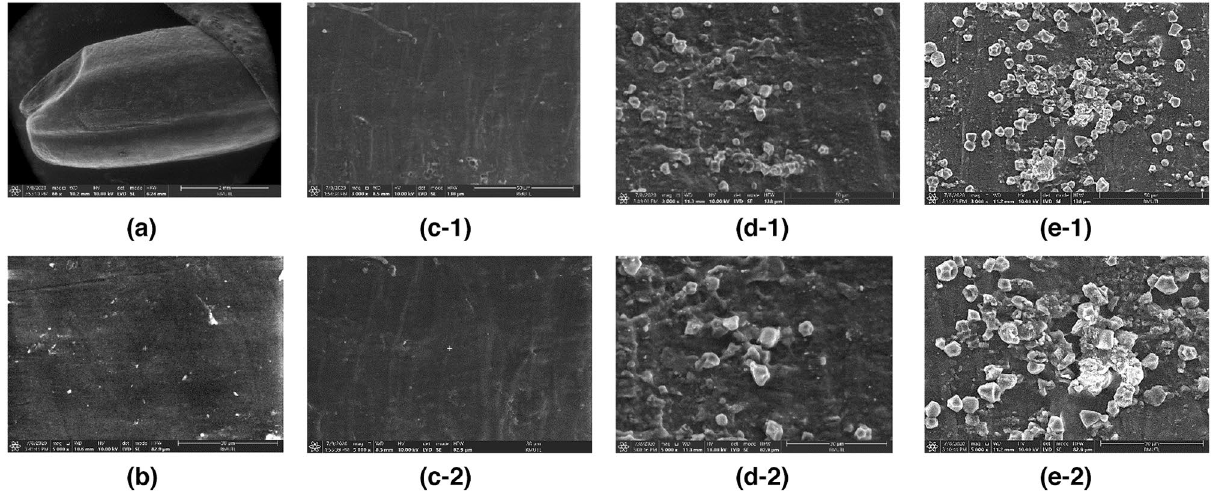
Figure 5. SEM of BRG during the PEF-AWE ( a ) position of SEM analysis ( b ) before soak in water in 5000x, ( c1-2 ) after soak in water 30 min in 3000 × and 5000x, ( d1-2 ) after pretreatment by PEF in 3000 × and 5000x, ( e1-2 ) soaking process after PEF for 6 h in 3000 × and 5000x.